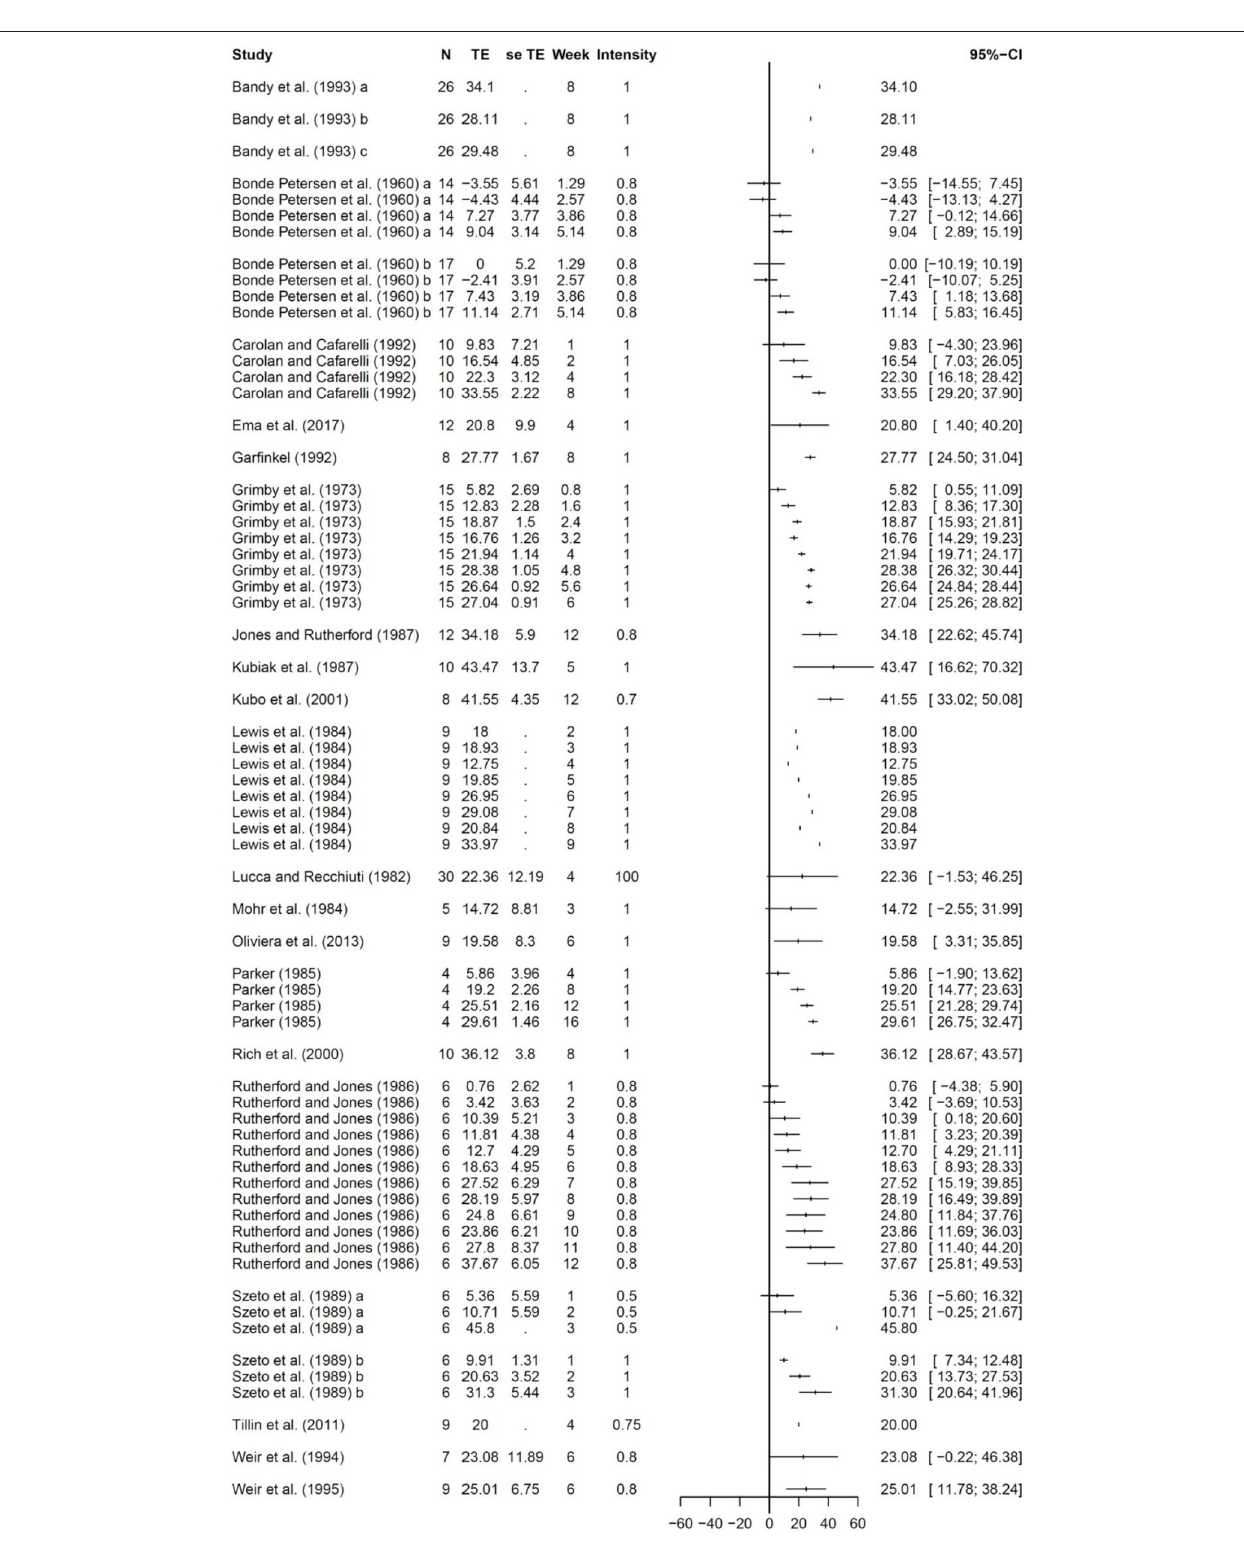
Frontiers in Sports and Active Living |